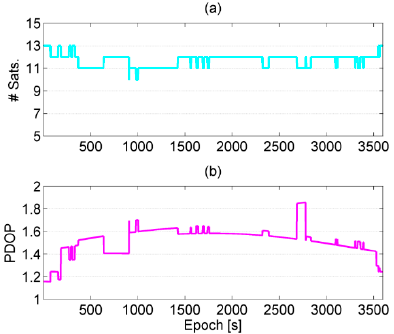
Figure 11. ( a ) Satellite numbers; and ( b ) PDOP values. The data are calculated from the C1 observations of dataset no. 2.